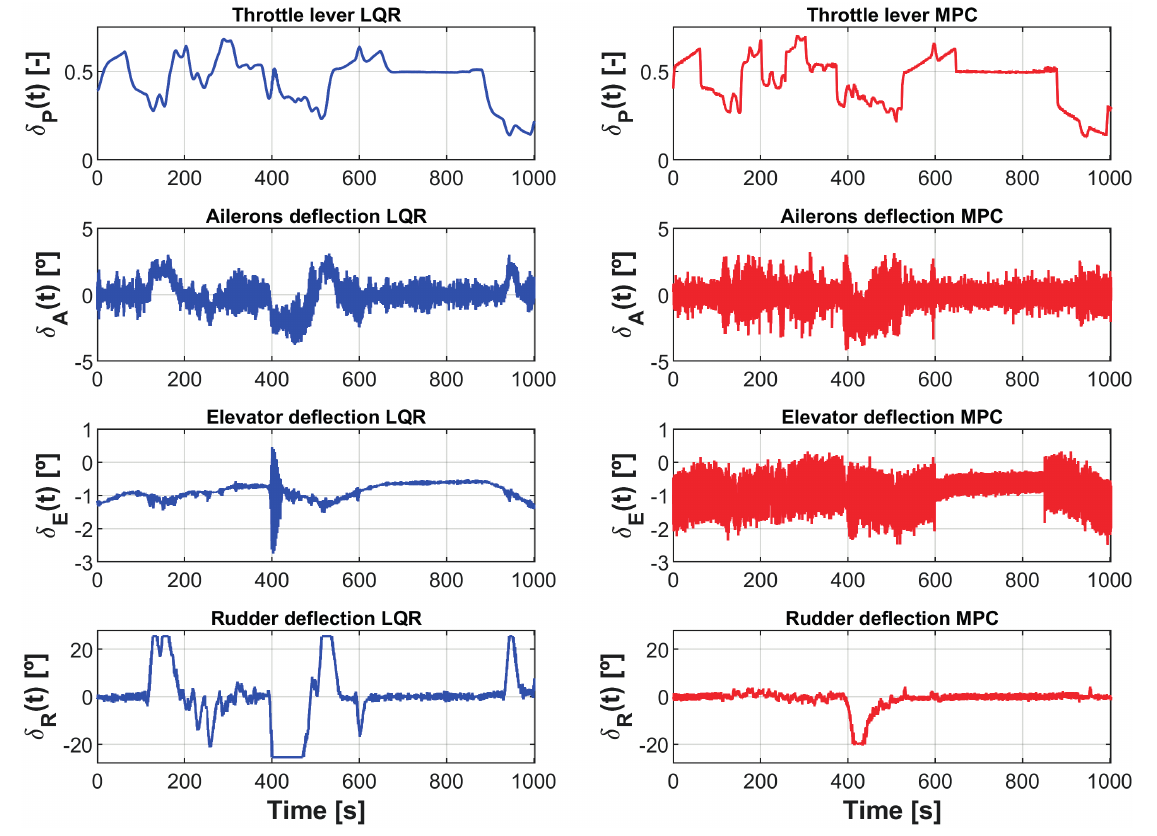
Figure 12. Control actions by the LQR (blue) and MPC (red) controllers: the throttle lever ( δ P ) and elevator ( δ E ), ailerons ( δ A ), and rudder ( δ R )